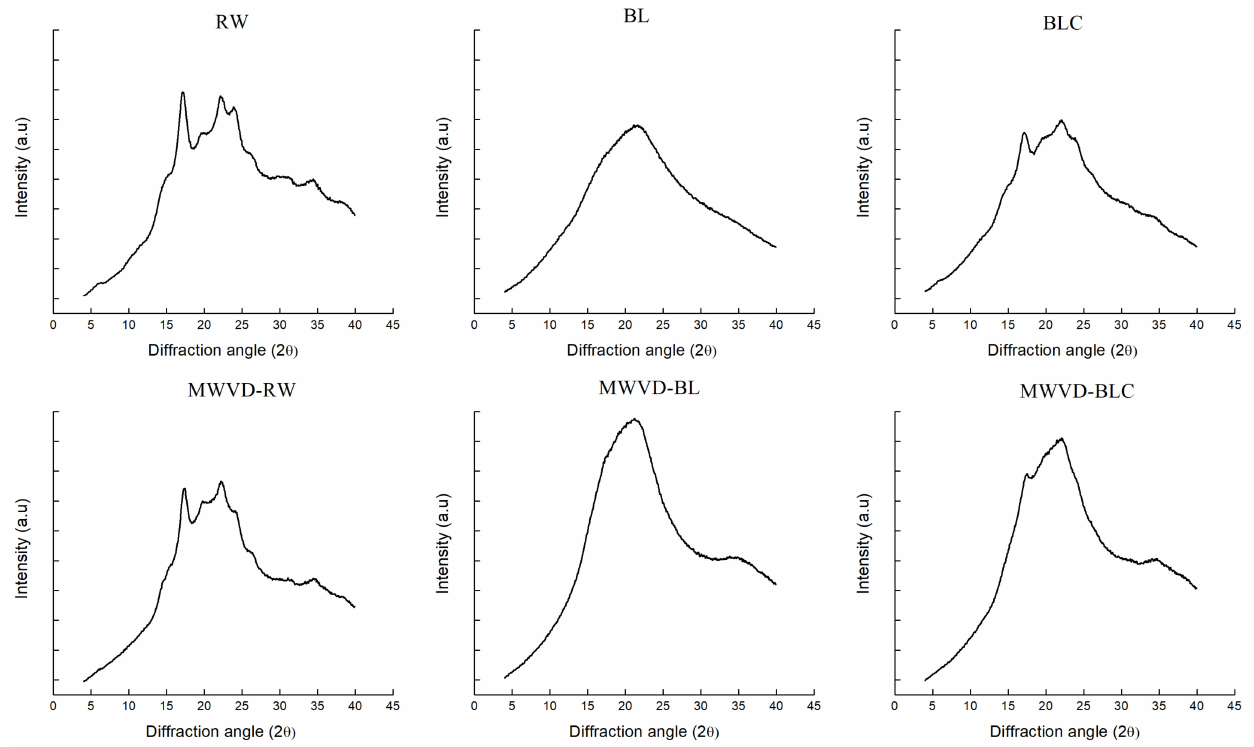
Figure 3. X-ray diffraction pattern of fresh (RW, BL, BLC) and dried (MWVD-RW, MWVD-BL, MWVD-BLC) potato